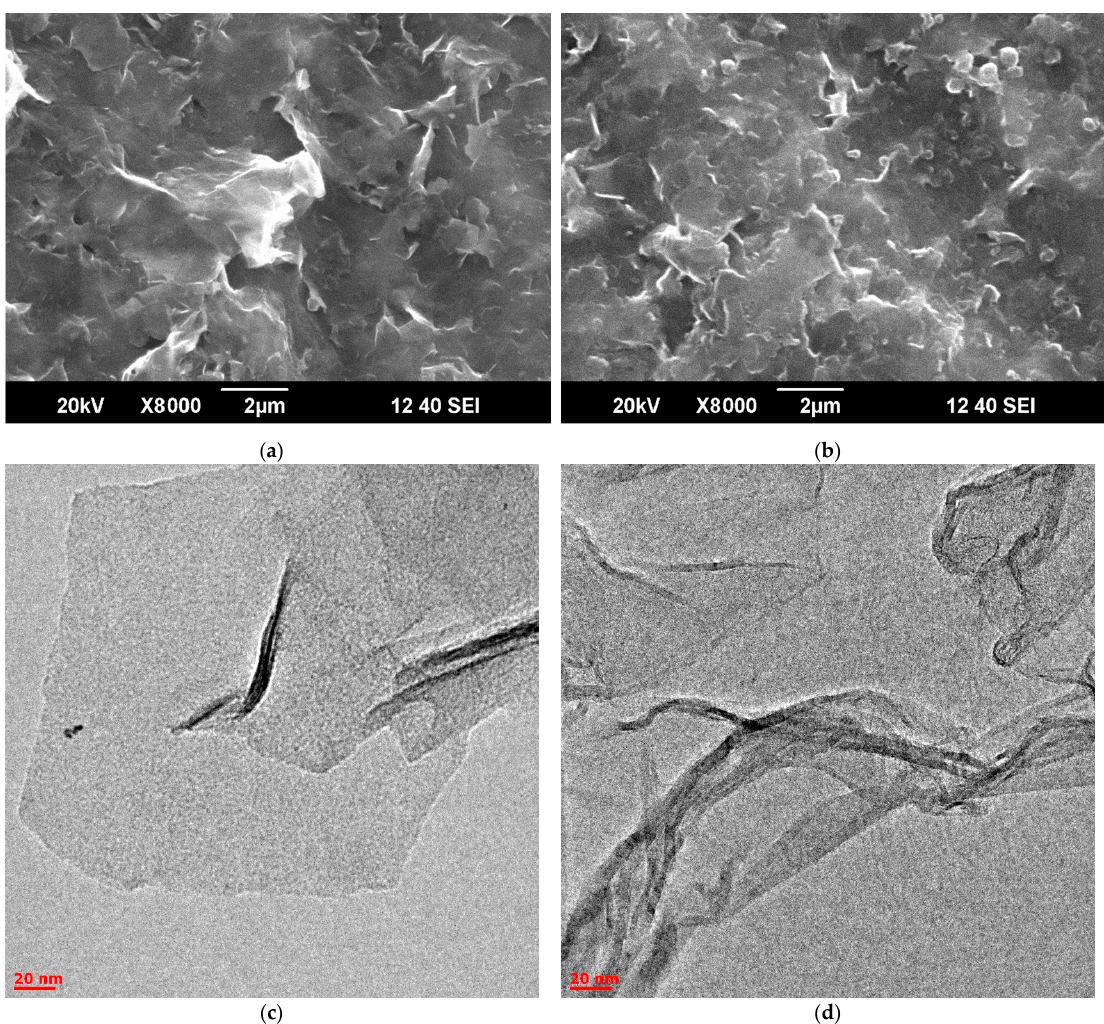
Figure 6. SEM images: ( a ) EGO 2, two-step synthesized samples of EGO with a separated cathode– anode compartment with additional current treatment and a platinum rod as an anode (procedure 3); ( b ) EGO 5, one-step synthesized samples of EGO with a separated cathode–anode compartment without further current treatment (procedure 5). HRTEM images: ( c ) EGO 2; ( d ) EGO 5.